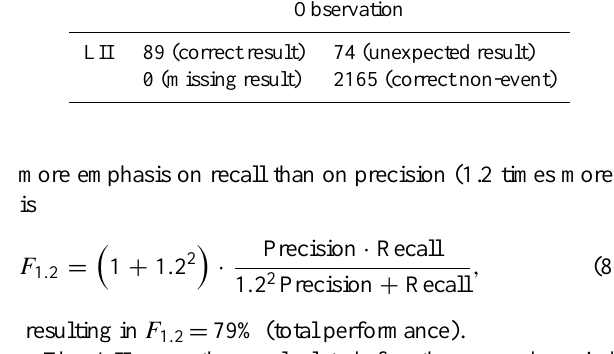
Table 2. LII: consistency table for the period 1 June 2008 to 30 June 2011. Observation LII